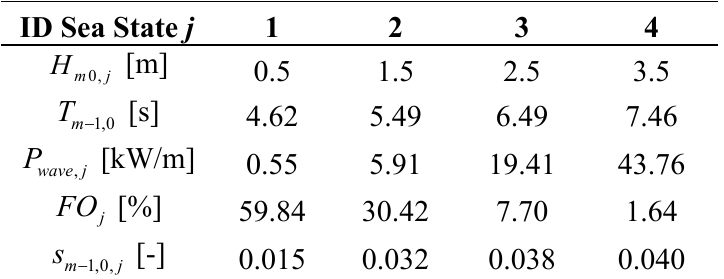
Table 5. Characteristic sea states for location on the Dutch Continental Shelf (MPN), h = 18 m, source scatter diagram: Rijkswaterstaat [9]. t